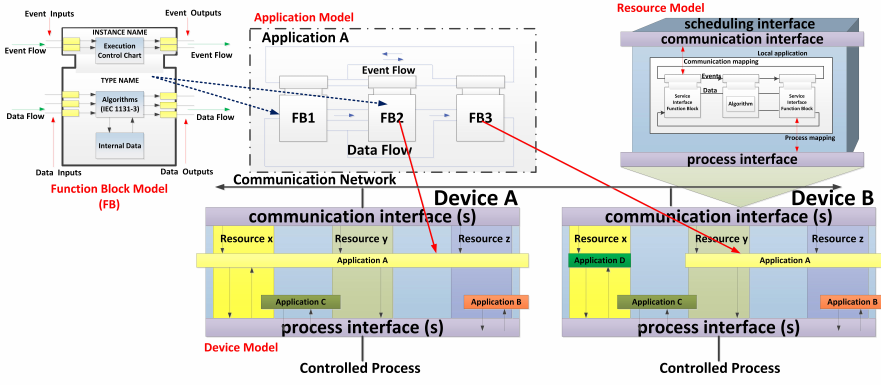
Figure 1. IEC-61499 Architecture